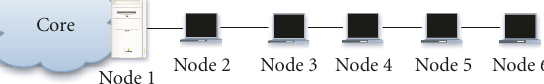
Figure 6: Topology of the indoor tests.